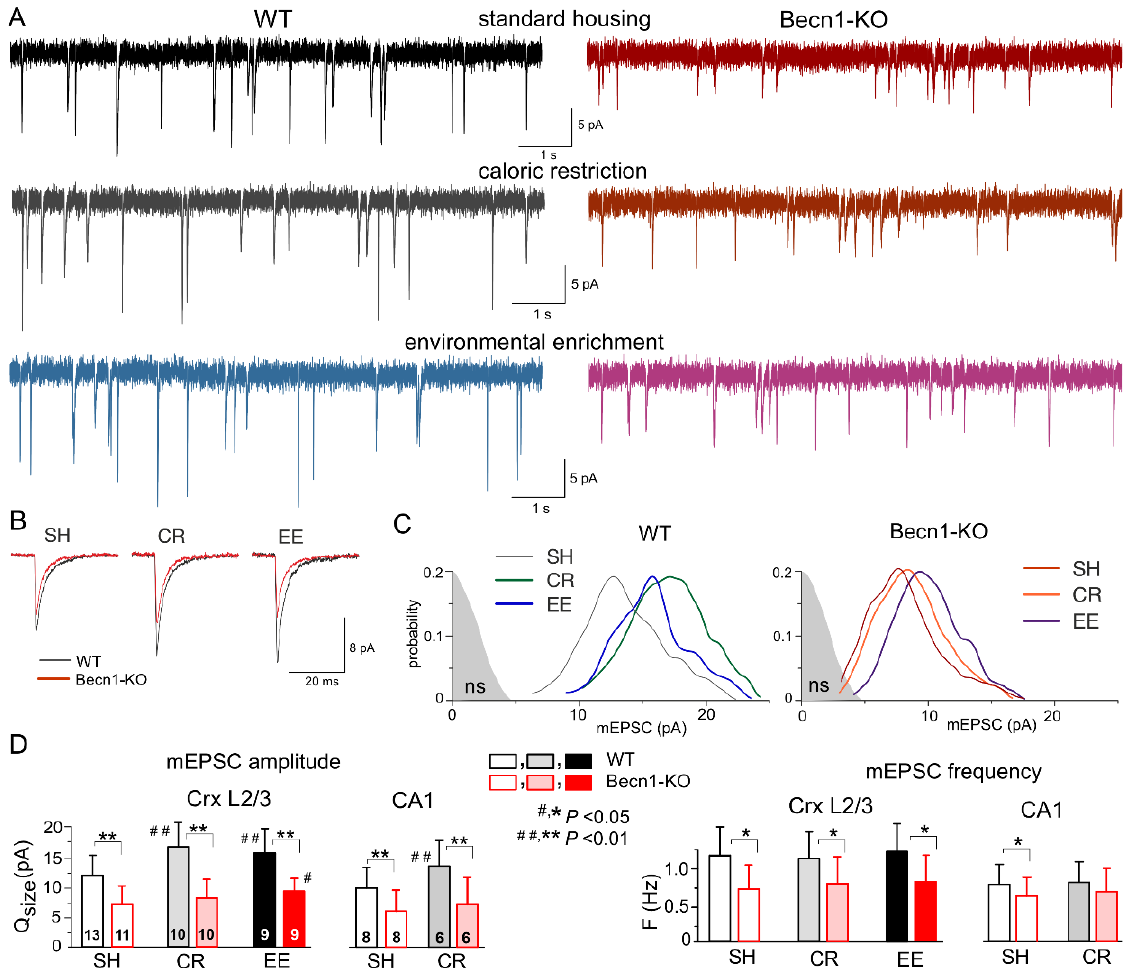
Figure 4. Impact of autophagy impairment on baseline excitatory synaptic transmission and home- ostatic synaptic plasticity. The AMPA receptor-mediated miniature excitatory synaptic currents (mEPSCs) were recorded in the neocortical and hippocampal pyramidal neurons at − 80 mV in the presence of 100 µM picrotoxin, 1 µM TTX and 10 µM PPADS. ( A ) The representative whole-cell currents recorded in the neocortical layer 2/3 neurons of the Becn1 +/+ (left column) and Becn1 +/− (right column) mice in standard housing (top row) and exposed to CR (middle row) and EE (bottom row). ( B ) The average mEPSC waveforms recorded under different conditions, as indicated (average of 20 mEPSCs each). Note the significant decrease in the mEPSC amplitude in the Becnlin1-deficient mice. ( C ) The corresponding amplitude distributions (probability density functions calculated for 300–600 events); the shaded areas show the amplitude distribution of background noise. The post- synaptic decrease in the quantal size of mEPSCs in the Beclin1-deficient mice (as compared to WT) was evidenced by the leftward shift of the peak of amplitude distribution. Note that the amplitudes of most of the mEPSCs in the neuron of Beclin1-deficient are still above the noise. ( D ) Diagrams show the quantal size (evaluated as shown in panel C ) and frequency of the mEPSCs recorded in the layer 2/3 and CA1 pyramidal neurons of WT and Beclin1-deficient mice of different environment groups; data are shown as means ± SDs for the numbers of neurons indicated. The asterisks (* or **) correspondingly indicate the statistical significance of the difference between the Becn1 +/+ and Becn1 +/ − mice. The hash symbols (# or ##) indicate the statistical significance of the effects of CR or EE as compared to the SH mice of the same genotype. Note the significant decrease in the quantal amplitude and frequency of mEPSCs in the Beclin1-deficient